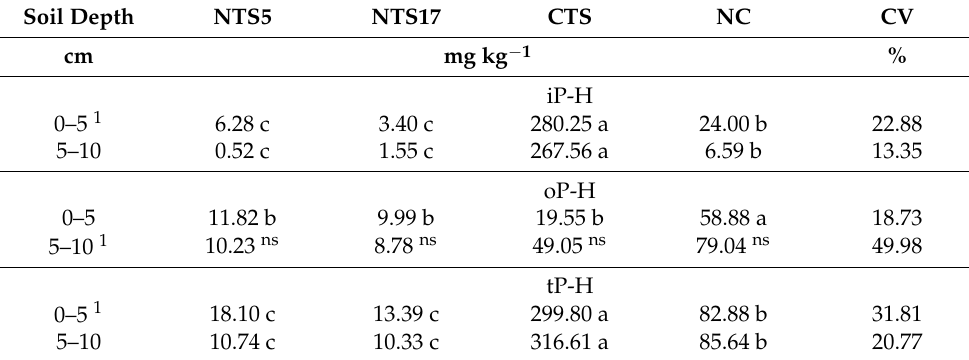
Table 5. Moderately labile portion of inorganic P (iP-H), organic (oP-H), and total (tP-H) from the soil extracted in sulfuric acid solution (H 2 SO 4 ) in the different management systems.